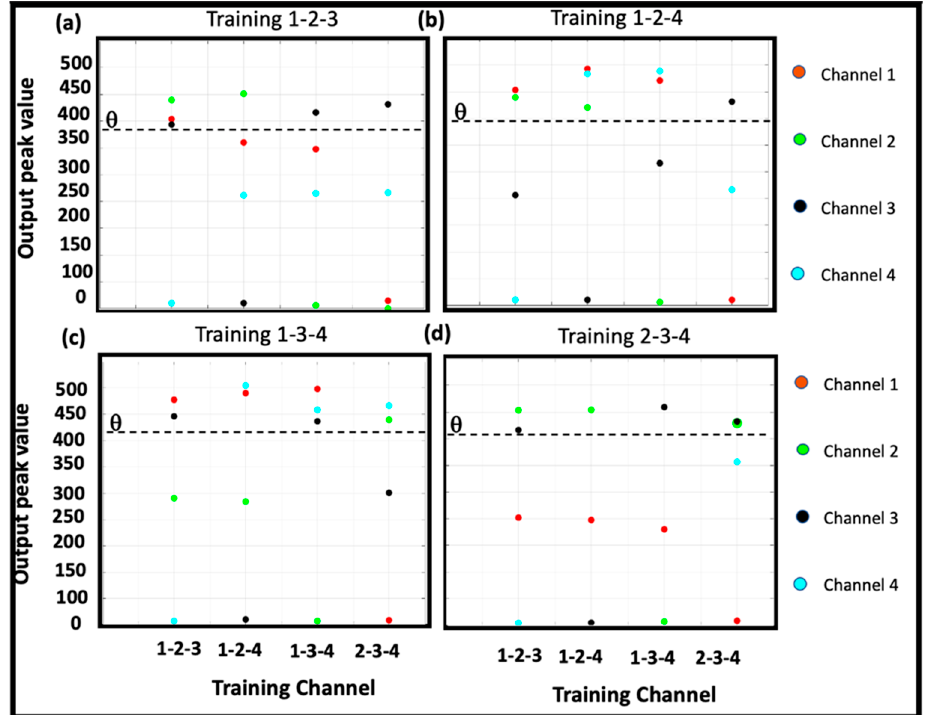
Figure 14. Amplitudes of the output signals for the different training 2-digit, 4-bit numbers. As shown, for each training number, there is only one case in which both outputs exceed the threshold (dashed horizontal line): ( a – d ) report the cases of validation after having trained the possible combinations of channels respectively. However, the network is able to recognize also single trained